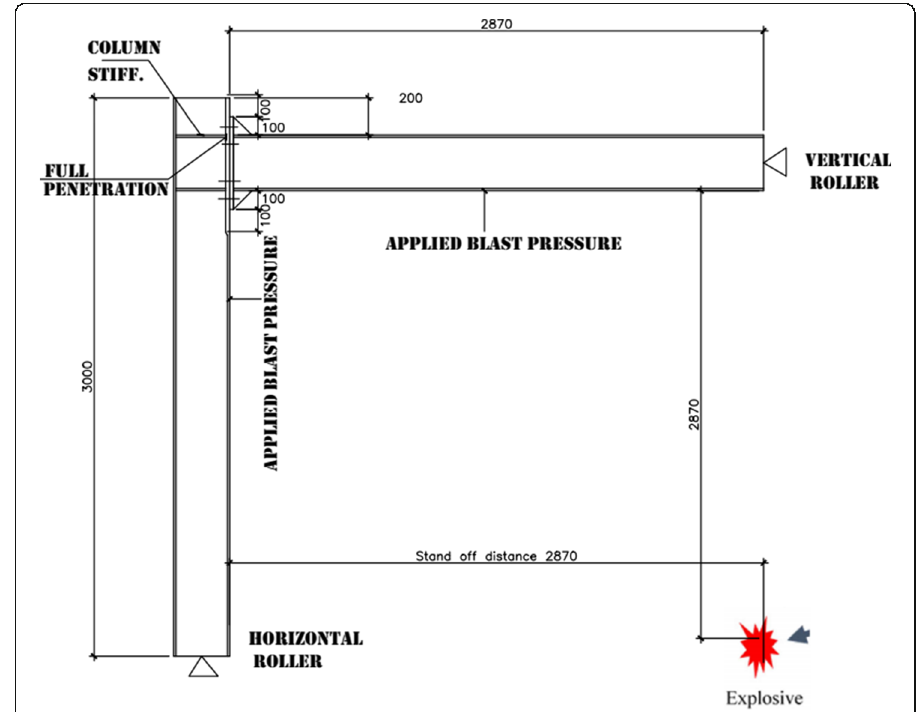
Fig. 21 Blast pressure application on both column and beam inside flanges